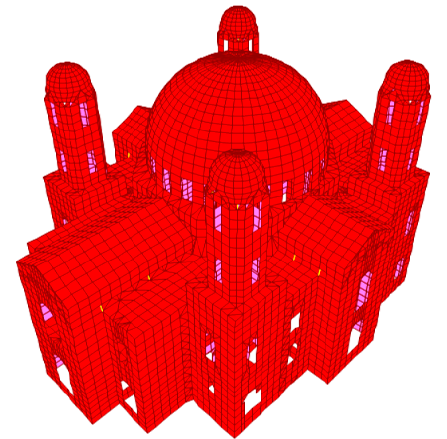
Figure 9. Formation of the 3-D numerical approximation.